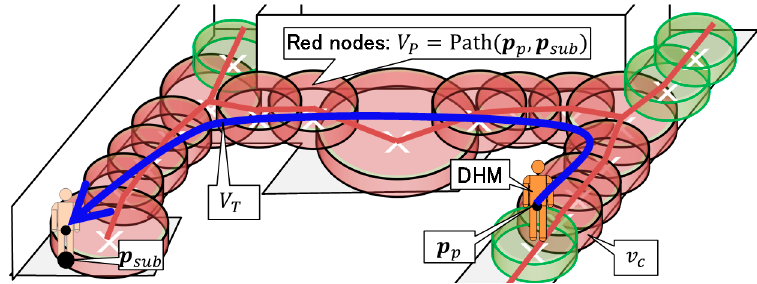
Figure 9. Examples of walking path selection and walking trajectory generation.